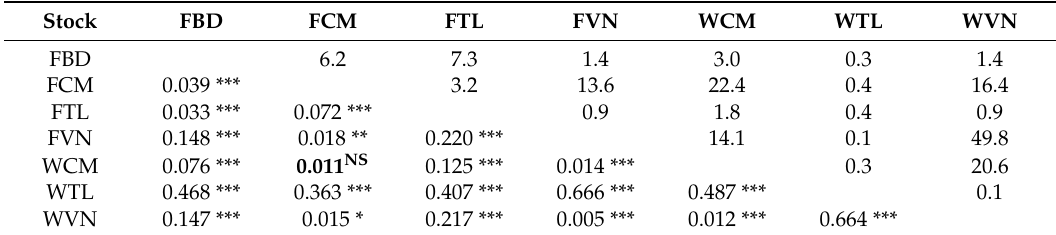
Table 3. Pairwise F ST genetic distance (below diagonal) and gene flow Nm (above diagonal) between populations.